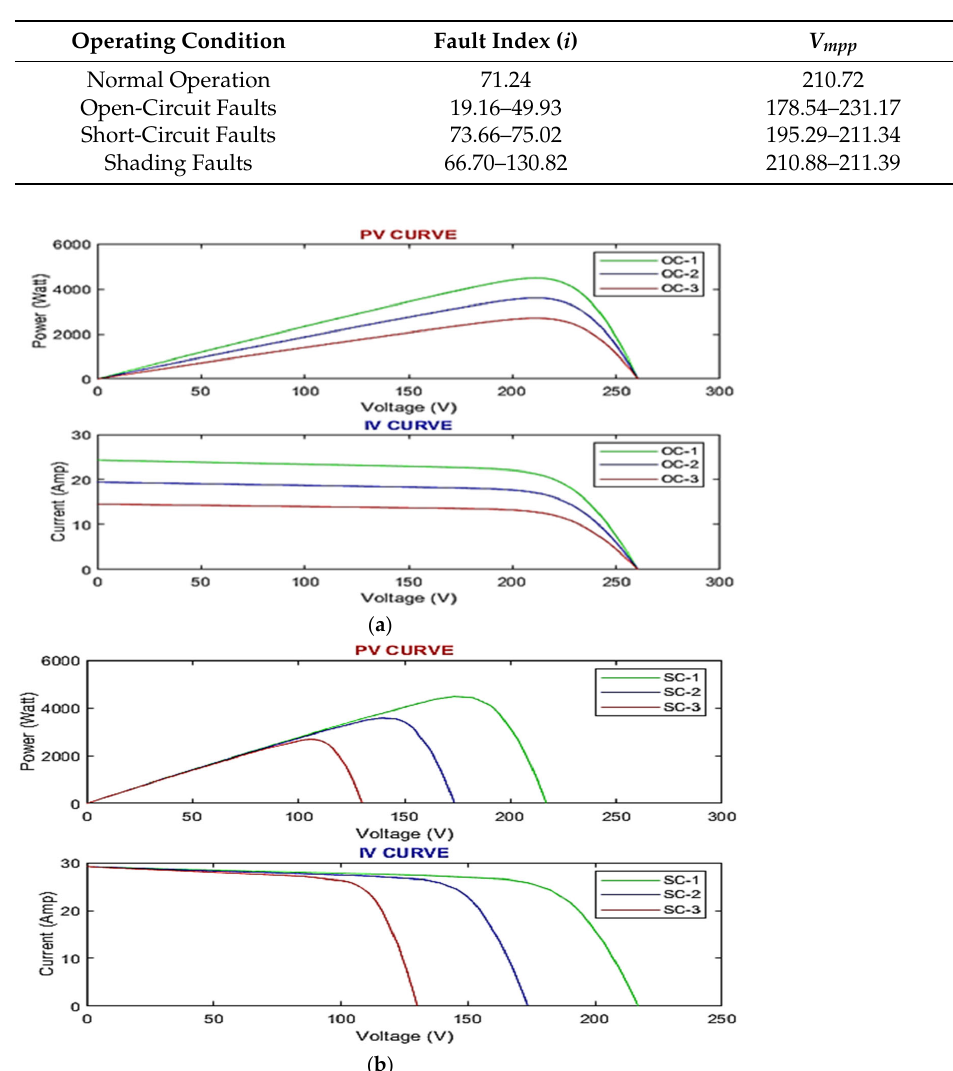
Figure 3. Fuzzy rule view. ( a ) Open ‐ circuit fault. ( b ) Short ‐ circuit fault. ( c ) Shadowing fault. Table 6. Classification of PV faults.